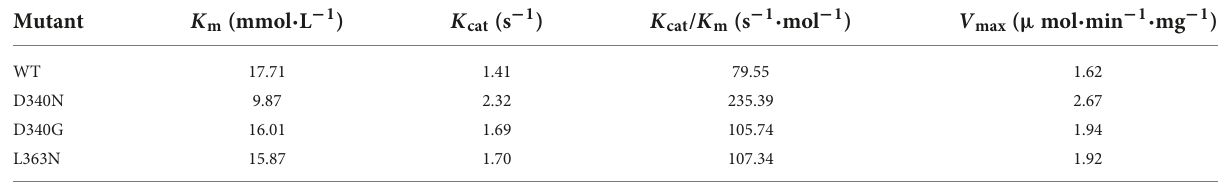
TABLE 2 Comparison of properties of the wild-type (WT) and mutants (D340N, D340G, and L363N). K m and K cat values were calculated by Michaelis–Menten equation. Mutant